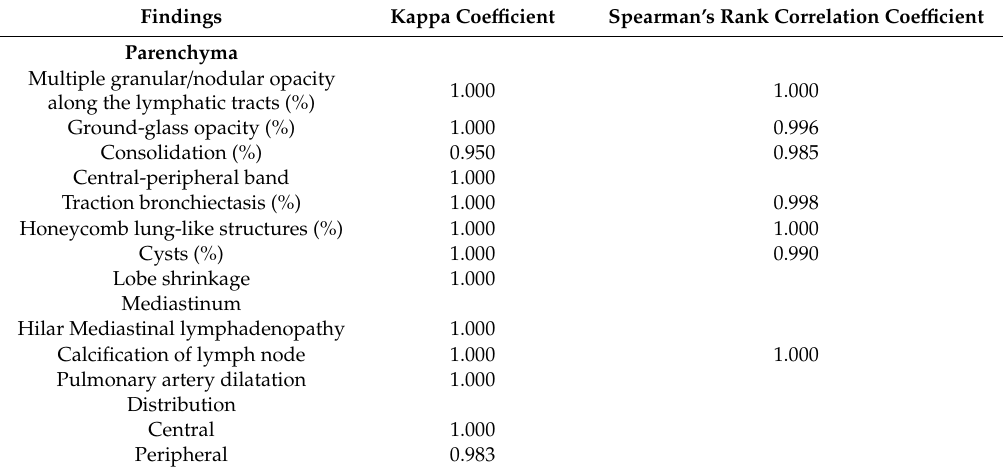
Table 2. Inter-class reliability.